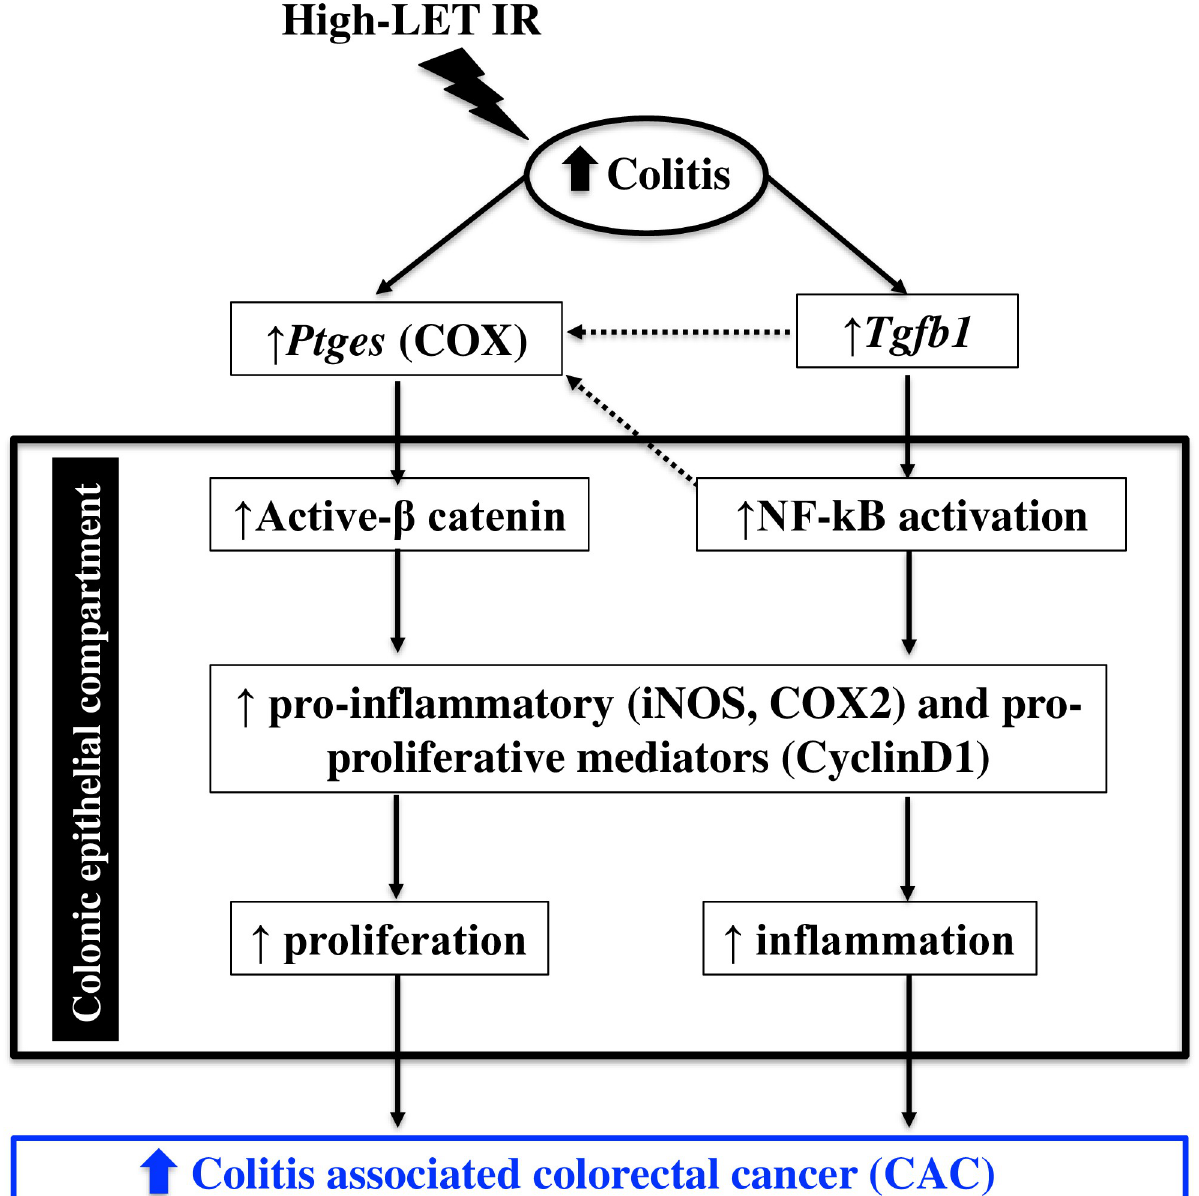
Fig 7. An illustrative summary of signaling events associated with heavy-ion radiation-induced colitis-associated colorectal cancer (CAC).